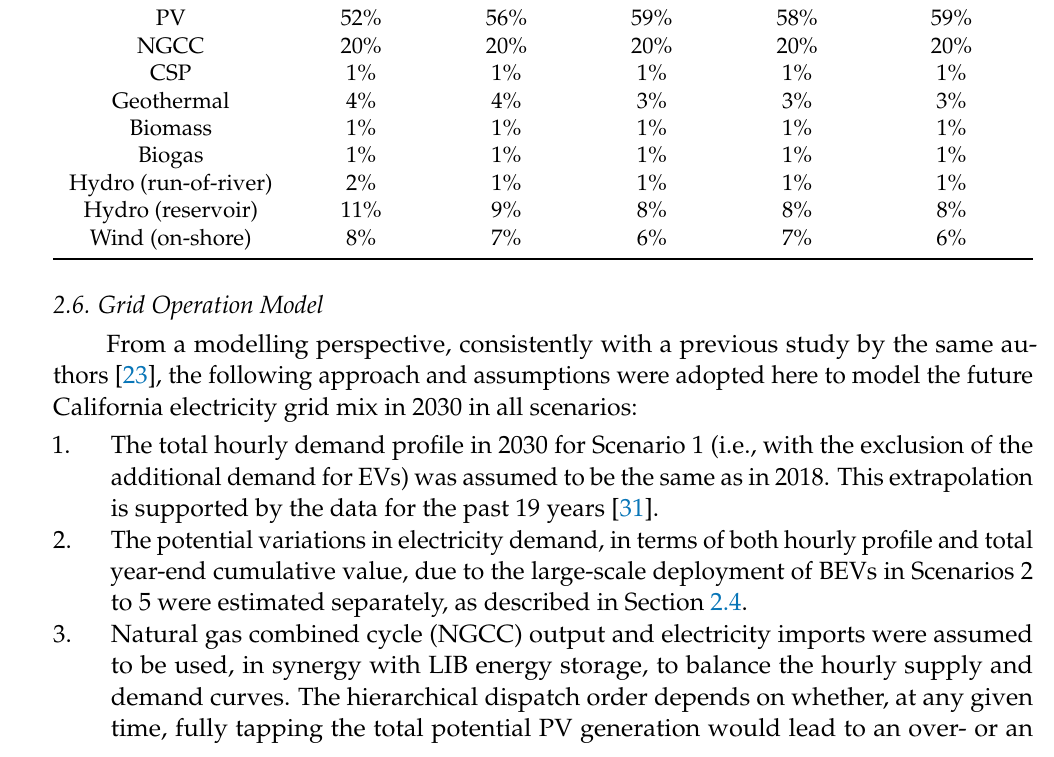
Table 2. Technology shares (net generation post-curtailment and storage) of the domestic California grid mix in 2030, in the five analysed scenarios. All values rounded to the nearest 1%.